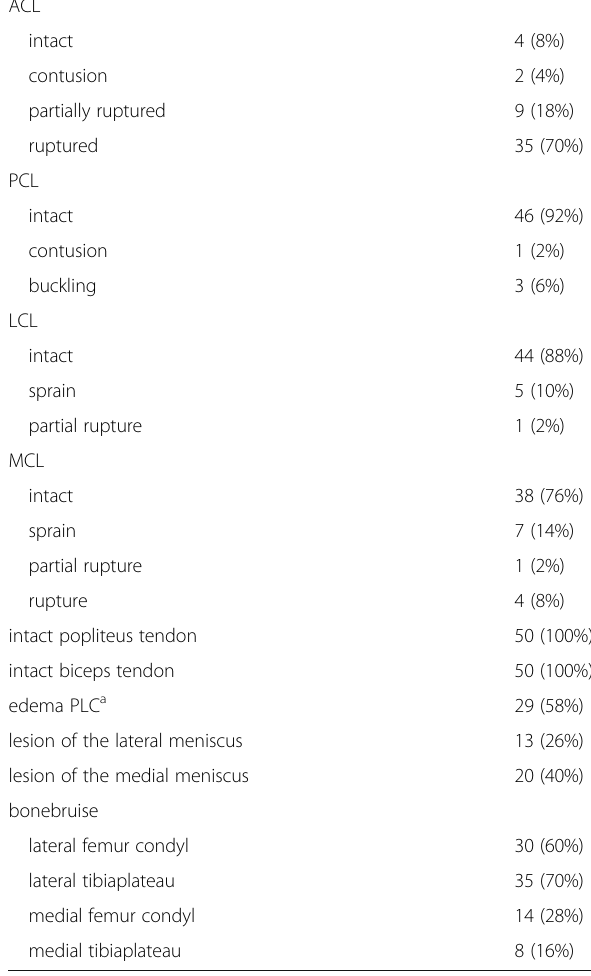
Table 5 Features on MRI of the injured knee of 50